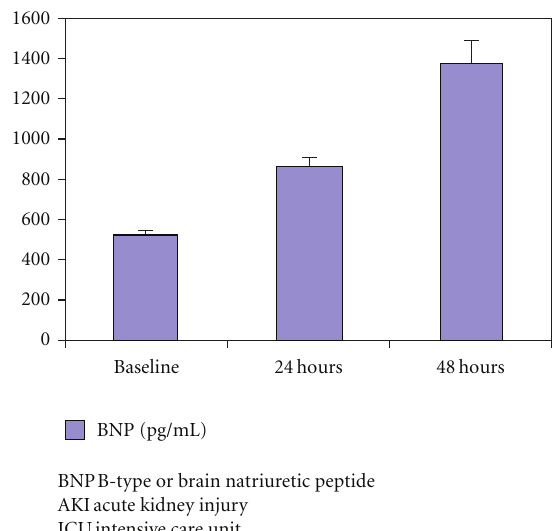
Figure 2: Increase in median of BNP of patients with AKI on admission to ICU ( P = .